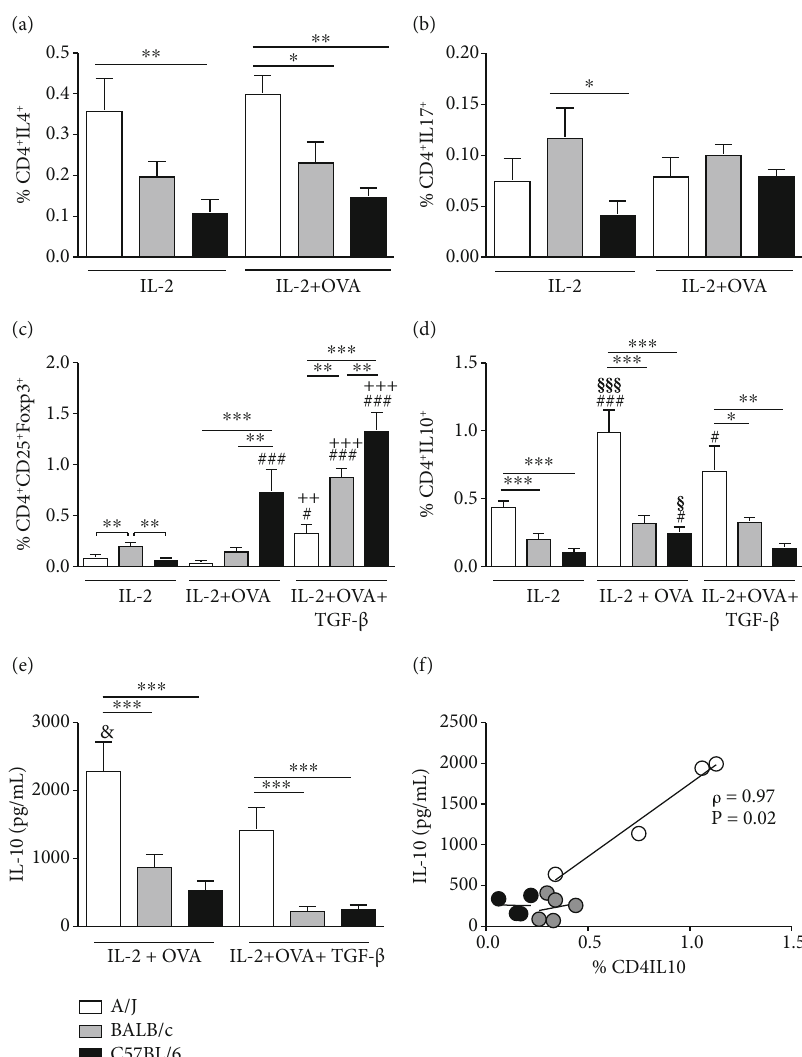
Figure 6: In vitro expansion of CD4 + IL4 + , CD4 + IL17 + , CD4 + CD25 + Foxp3 + , and CD4 + IL10 + cell populations from lymph nodes of A/J, BALB/c, or C57BL/6 OVA-challenged mice. Cells from mediastinal lymph nodes were cultured for 72h in the presence IL-2, IL-2 +OVA, or IL-2 +OVA + TGF- β , and subpopulations of CD4 + IL4 + (a) and CD4 + IL17 + (b) CD4 + CD25 + Foxp3 + (c) or CD4 + IL10 + (d) were analyzed by fl ow cytometry. IL-10 production in the supernatant of cultured cells was detected by ELISA (e). Values represent mean ± SEM of 4-5 animals per group. # P < 0 : 05 and ### P < 0 : 001 as compared to the same mouse strain group that received only IL-2. ++ P < 0 : 01 and +++ P < 0 : 001 as compared to the same mouse strain group that received IL-2 +OVA. § P < 0 : 05 and §§§ P < 0 : 001 as compared to the same mouse strain group that received IL-2+ OVA + TGF- β . & P < 0 : 05 as compared to the same strain between di ff erent stimulus. ∗ P < 0 : 05 , ∗∗ P < 0 : 01 , ∗∗∗ P < 0 : 001 . Correlation between frequency of CD4 + IL10 + cells and IL-10 production in cultures stimulated with OVA and TGF- β (f). Pseudo- r = 0 : 97 , P = 0 : 02 by univariate